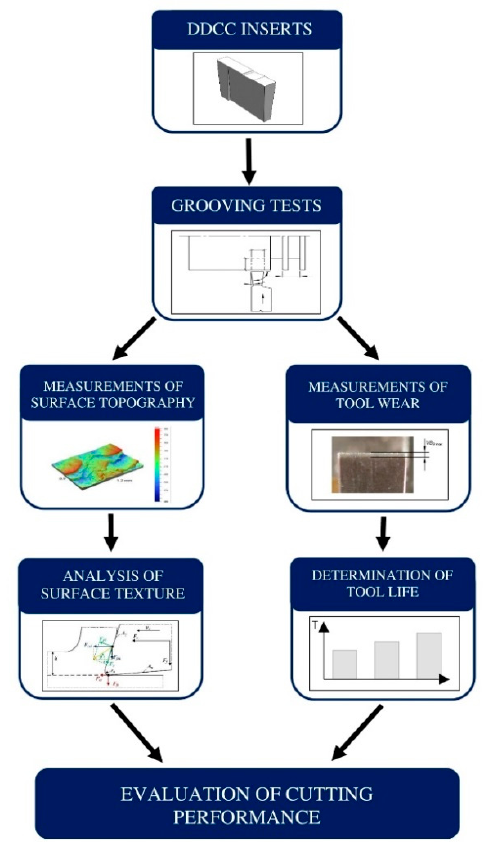
Figure 1. The flowchart of a carried out experiment.